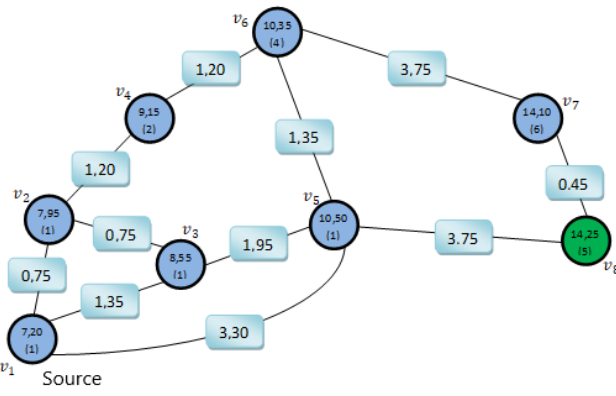
Figure 11. Finding the optimal path from peak 1—step 8.